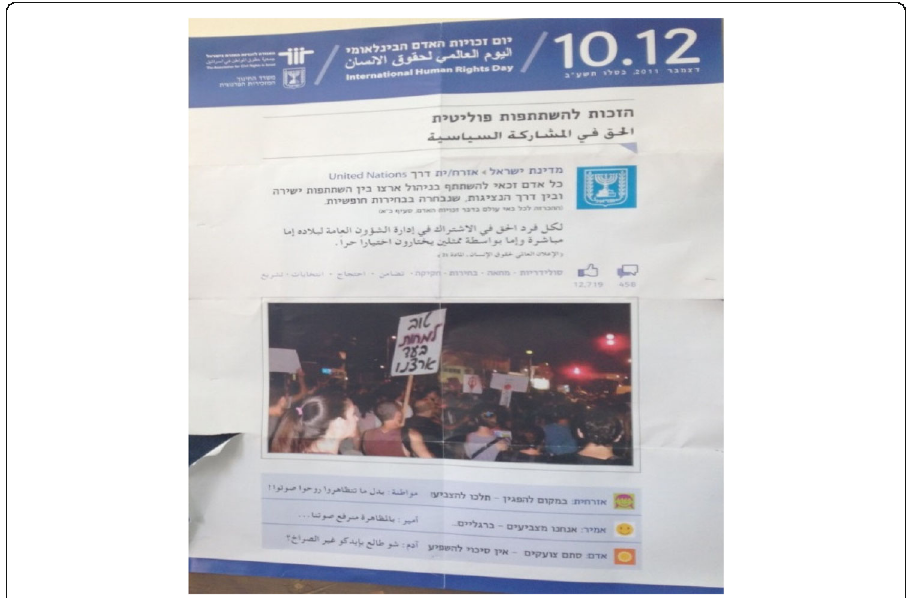
Fig. 5 Hebrew-Arabic schoolscape item